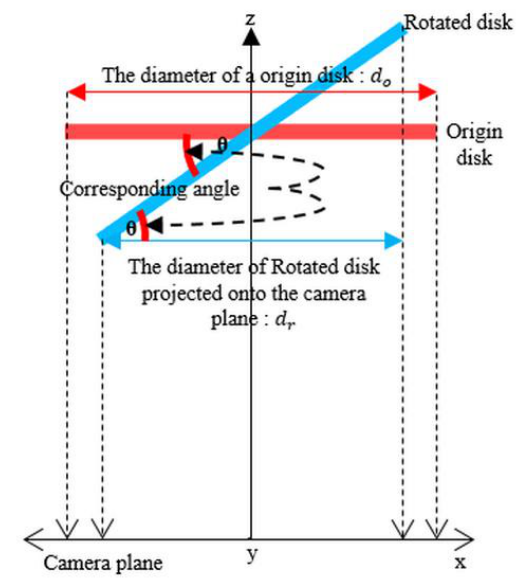
Figure 5. Principle of the disk being projected onto an ellipse. The length of the long axis is constant at d o even though θ , the rotation angle of the y-axis, varies. This is because there is no change in the distance between the camera and the z-axis in that part of the disk that was in contact with the y-axis at the point where the rotation occurred. Based on this, it was expected that the length of the long axis would always be constant even if rotation of the other axis occurred. To confirm this, the result was projected on the camera as each axis was rotated through all angles, as shown in Figure